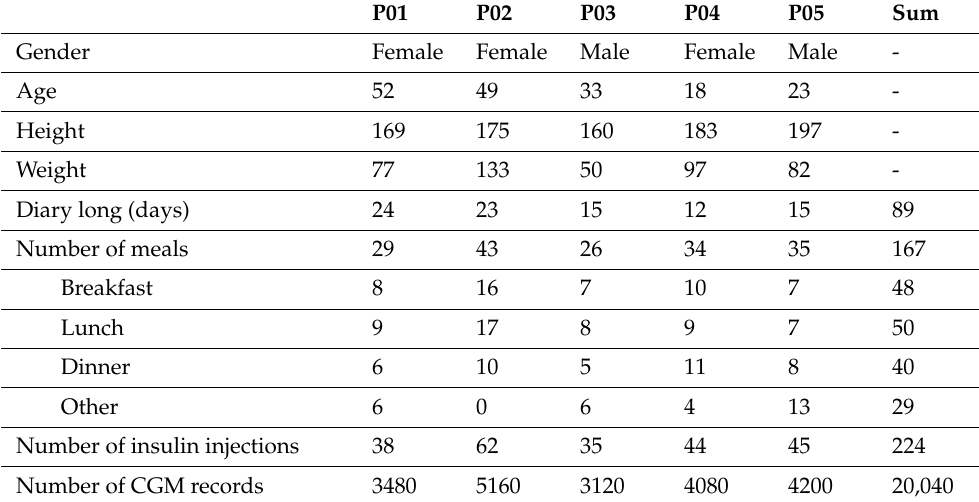
Table 2. Source data summary (data available for the study after data cleaning). P01 P02 P03 P04 P05